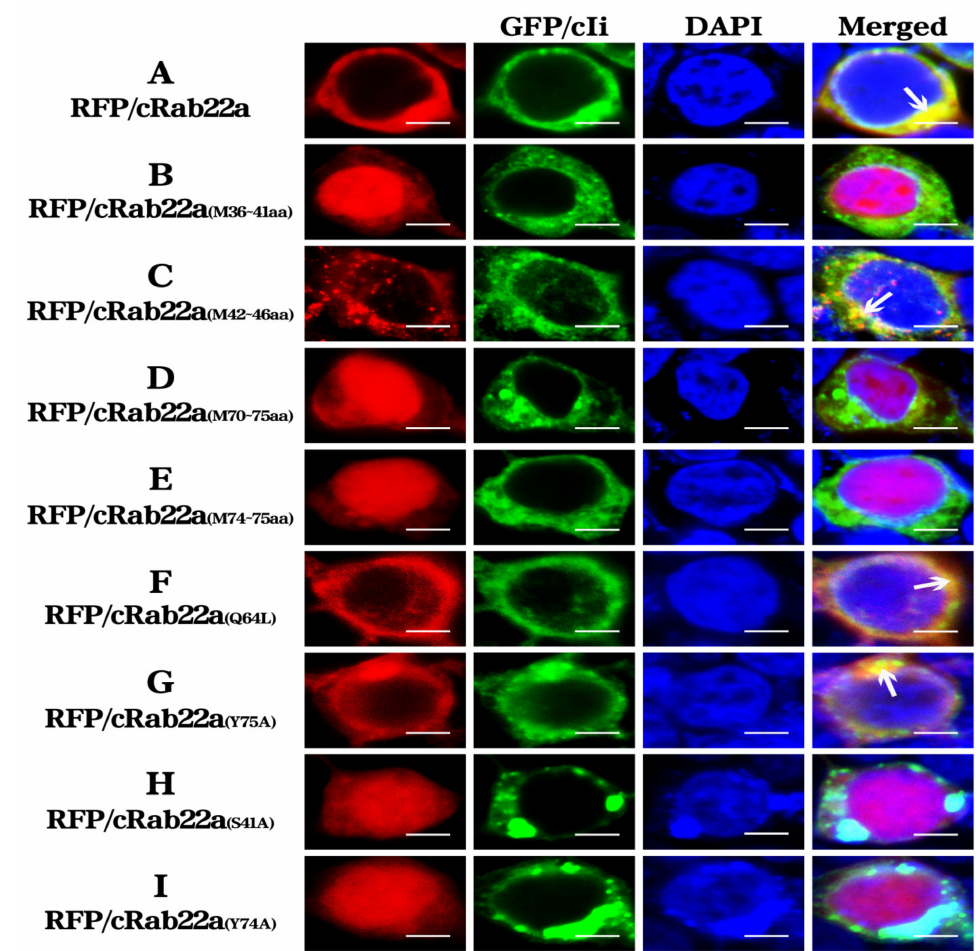
Figure 4. Co-localizations of RFP/cRab22a and its mutants with GFP/cIi in eukaryotic cells (400 × ). The arrows indicate the co-localization (linkage) of molecules (50 µ